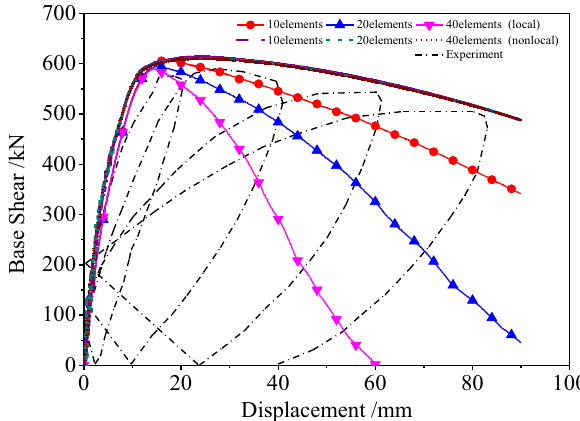
Fig. 16 Comparisons of the axial force time history in different characteristic